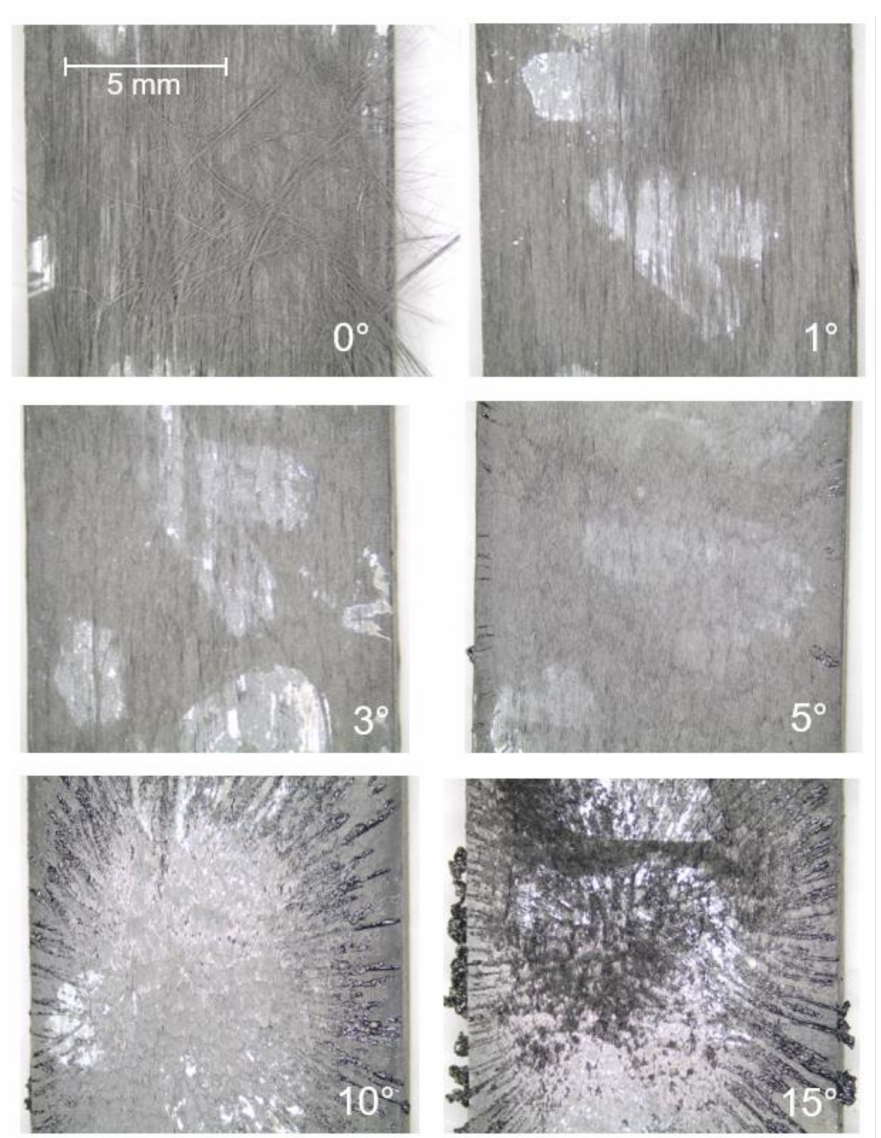
Figure 14. Images of the front side of samples with the given out-of-plane fibre angle after 60 s of the ablation